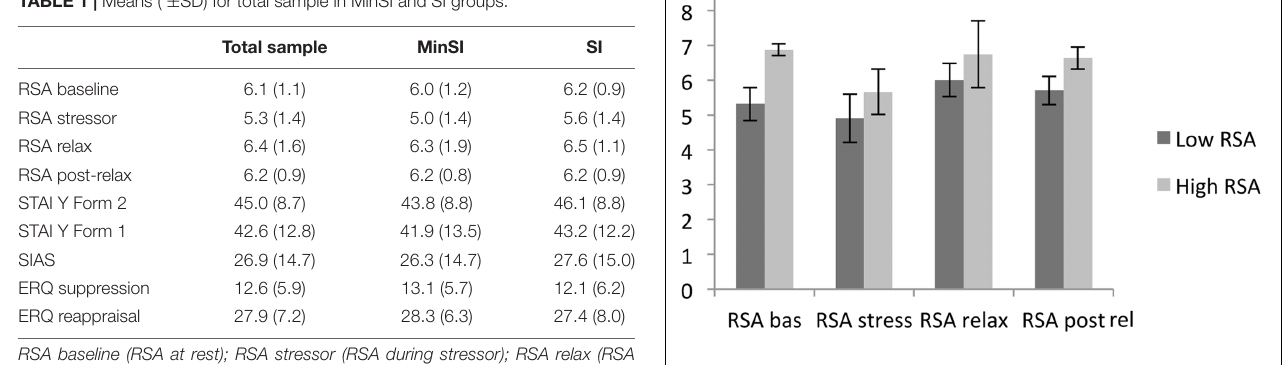
FIGURE 1 | Respiratory sinus arrhythmia (RSA) average levels during the four phases of the experiment. RSA bas (RSA baseline); RSA stress (RSA stressor); RSA relax (RSA relaxation); RSA post rel (RSA